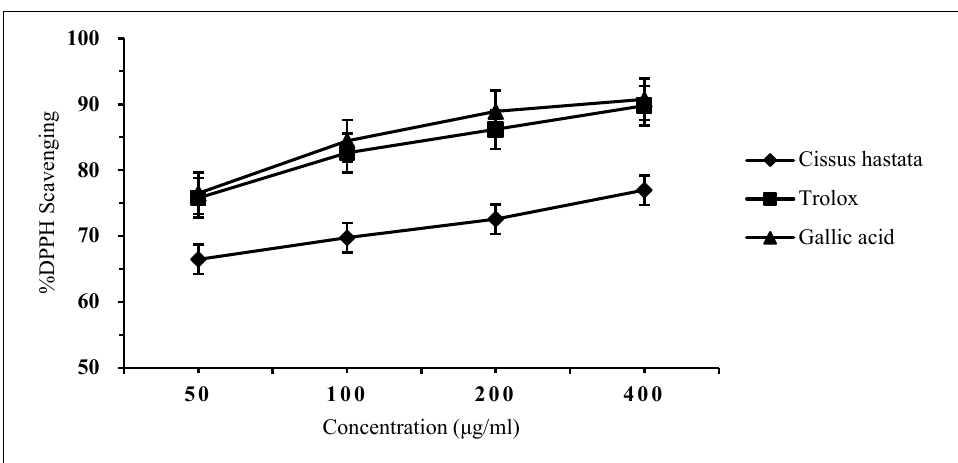
Figure 2. Inhibitory activity against DPPH by C. hastata methanolic leaf extract and the standards (trolox and gallic acid).